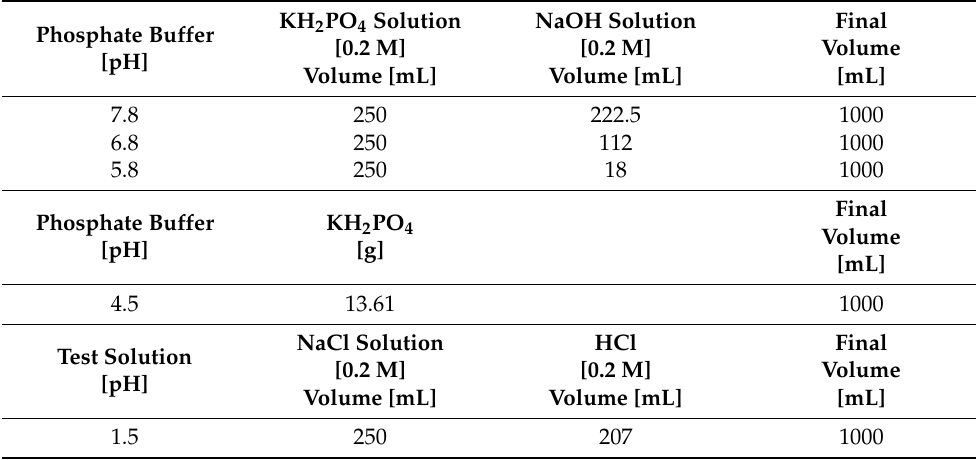
Table 2. Preparation of phosphate buffers and test solution. The single buffers were prepared from chemicals with the highest purification grade. Distilled water was used as solvent. pH values were fixed by the addition of either 0.1 M NaOH solution or 0.1 M HCl solution. The pH measurement was performed by the use of an electrode-pH meter with a temperature sensor (pH 3210i, WTW) at room